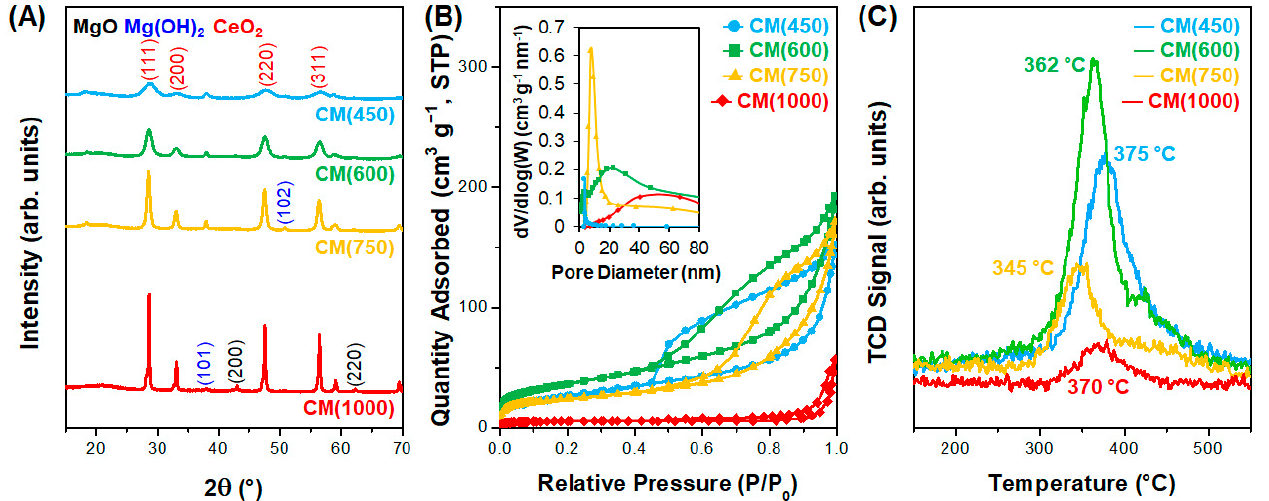
Figure 3. ( A ) X-ray diffraction patterns, ( B ) N 2 adsorption/desorption isotherms with pore size distributions (inset), and ( C ) CO 2 temperature-programmed desorption profiles of CeO 2 –Mg(OH) 2 after calcination at different temperatures: 450 °C (cyan), 600 °C (green), 750 °C (yellow), and 1000 °C (red).